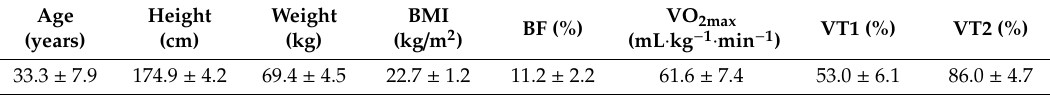
Table 1. Baseline general characteristics of the study participants.